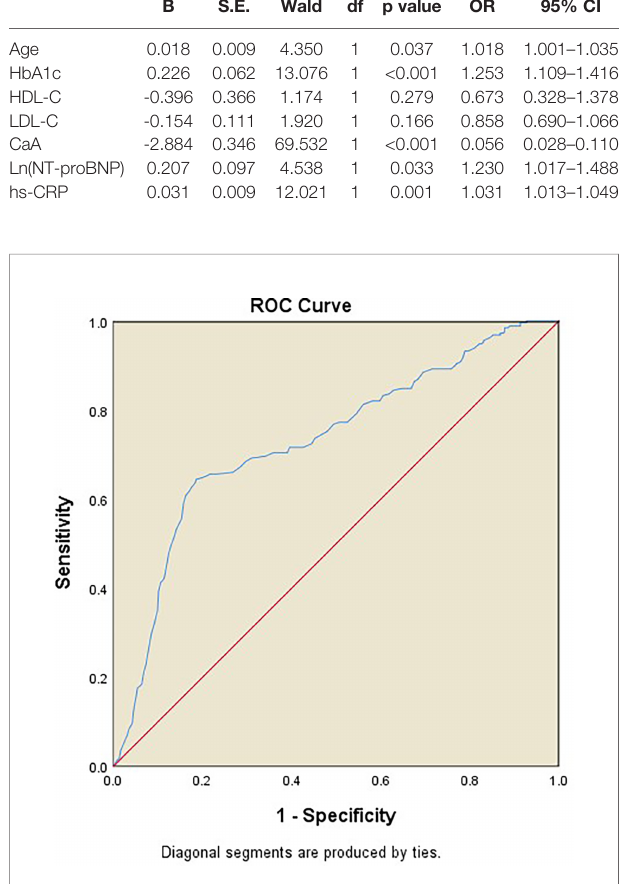
FIGURE 1 | ROC curves of CaA on prediction of HRV. The AUC in the ROC curve was 0.730 [95% CI (0.750 – 0.815), p < 0.001]. The cutoff value of CaA